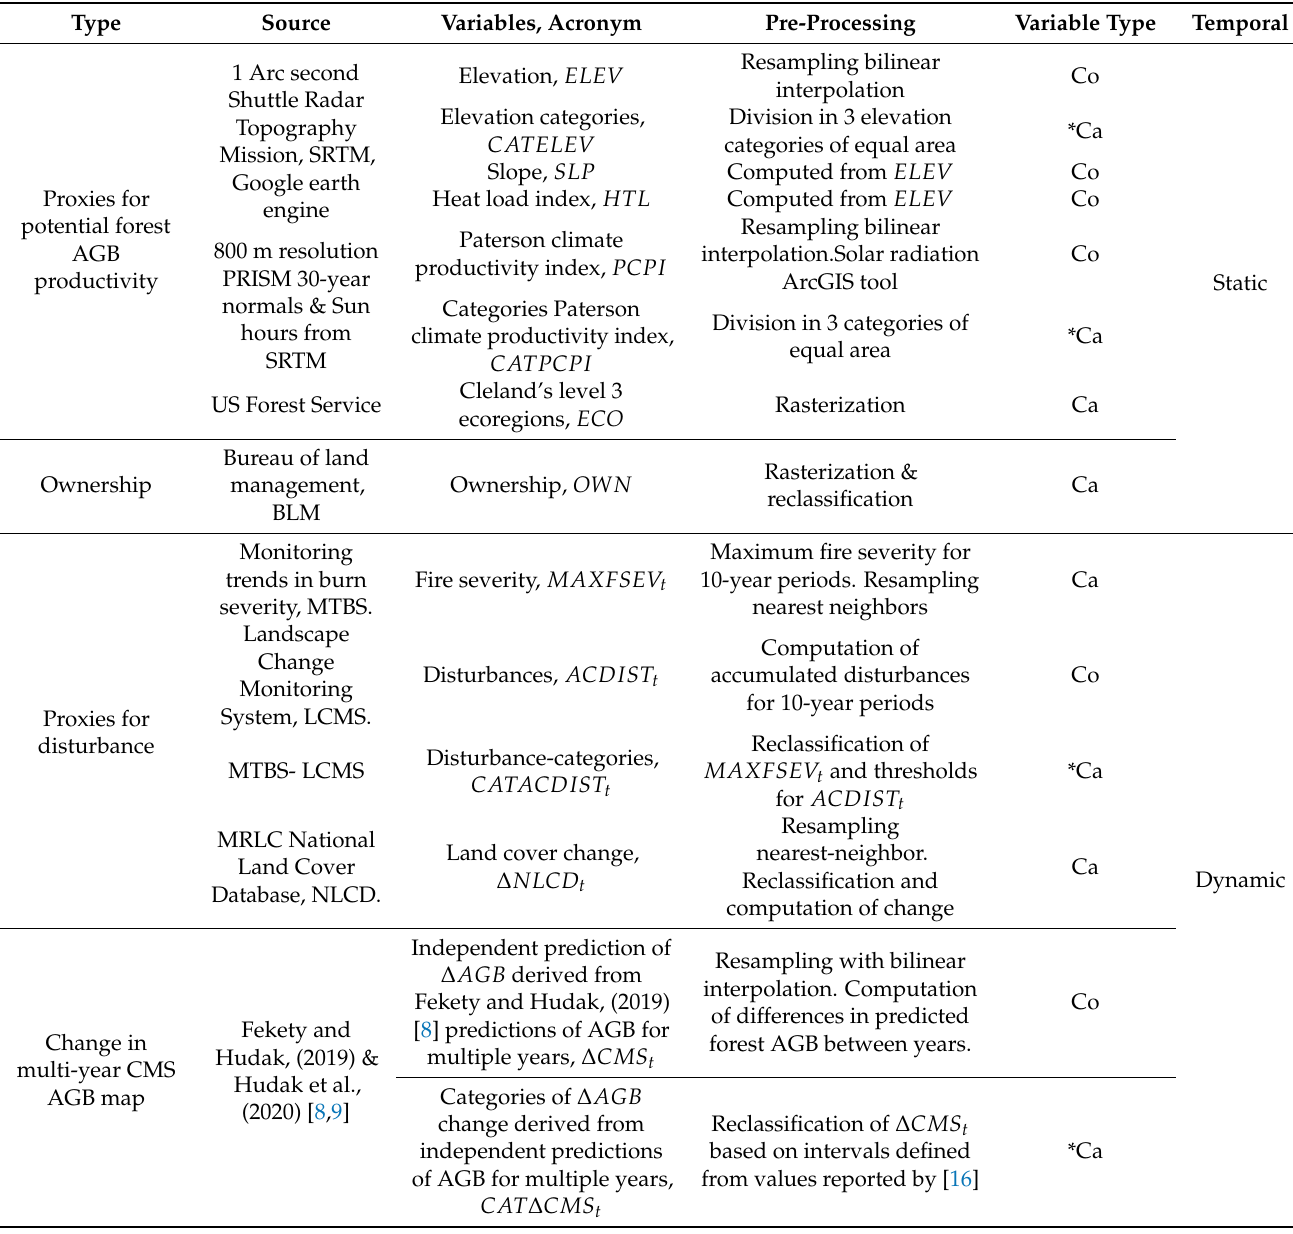
Table 1. Auxiliary information database summary. Categorical variables (Ca), Continuous variables (Co). Categorical variables derived from continuous ones are marked with an asterisk (i.e.,